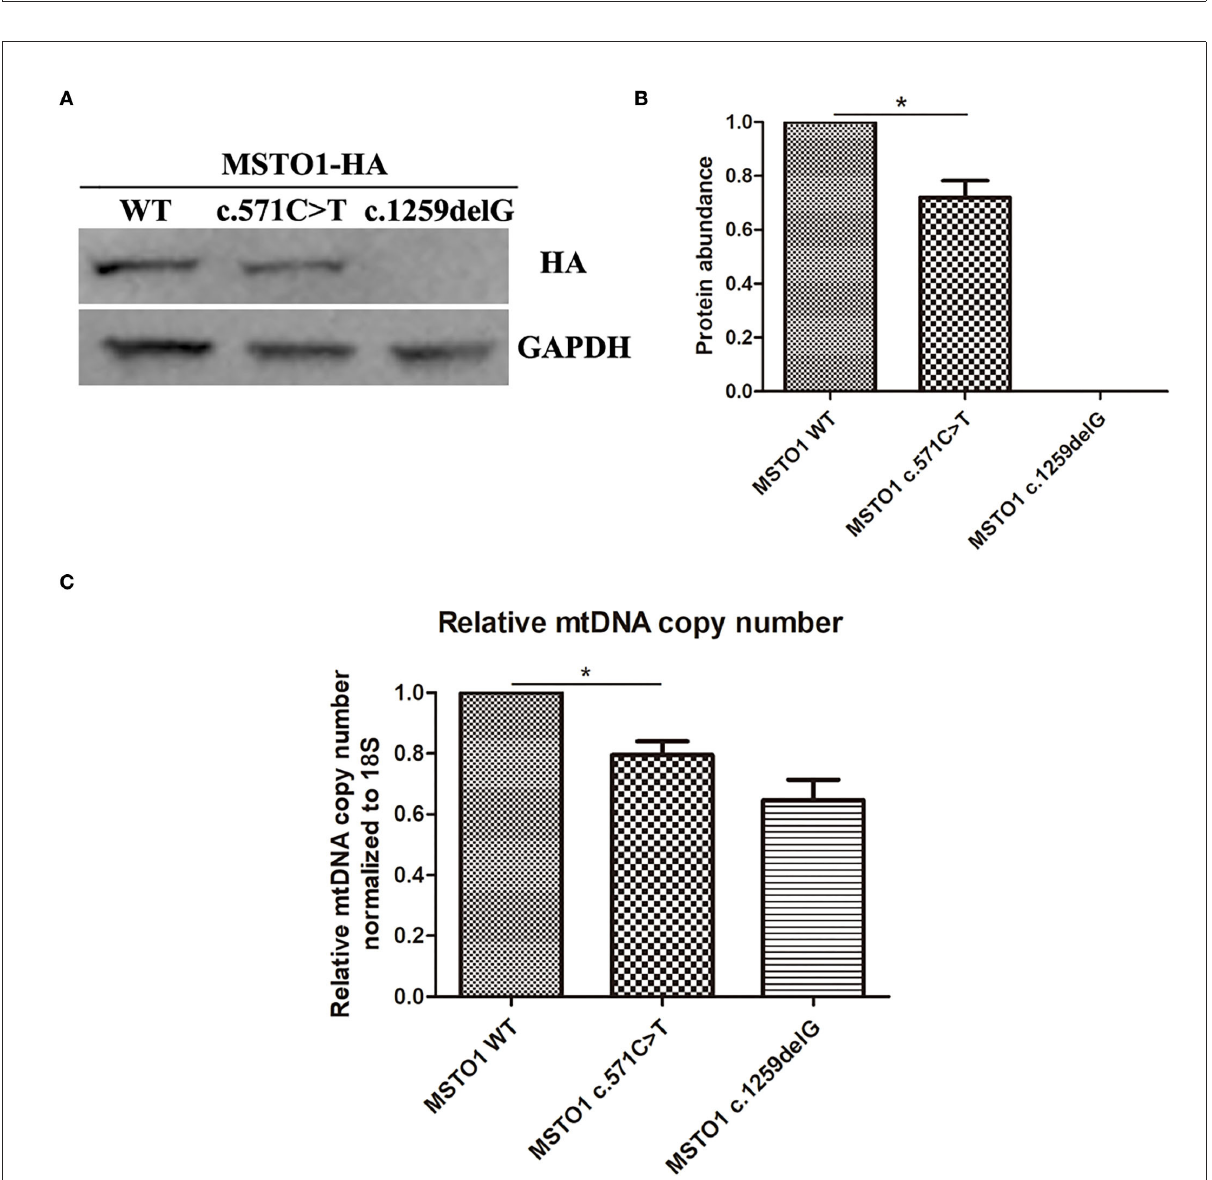
FIGURE3 The pathogenic variants in MSTO1 lead to reduced protein abundance and link to decreased mtDNA copy number. (A) Western blot analysis of total cell lysates from HEK293T cells overexpressing the HA-labeled wildtype, c.571C > T and c.1259delG mutants of MSTO1 proteins. (B) Protein abundance analysis of the wildtype, c.571C > T and c.1259delG mutants of MSTO1 proteins normalized to GAPDH. (C) Relative mtDNA copy number normalized to the nuclear-encoded 18S gene. Data represent at least three independent biological replicates. Significance was determined by Student’s t test. * P < 0.05.